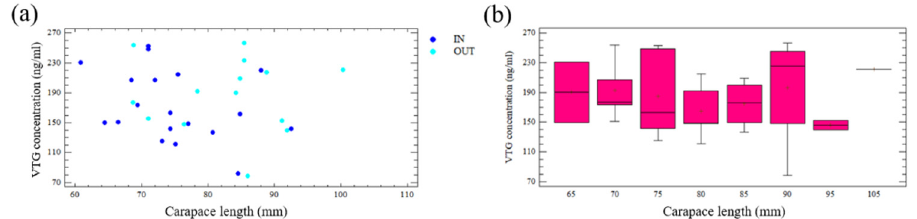
Figure 6. ( a ) Relationship between carapace length (mm) and relative VTG concentration of egg clutches at stage 2 of P. elephas females caught inside and outside FPAs (Su Pallosu and Buggerru); ( b ) mean VTG concentration of egg clutches at stage 2 of females in 5 mm CL size classes caught both inside and outside of the two FPAs together.